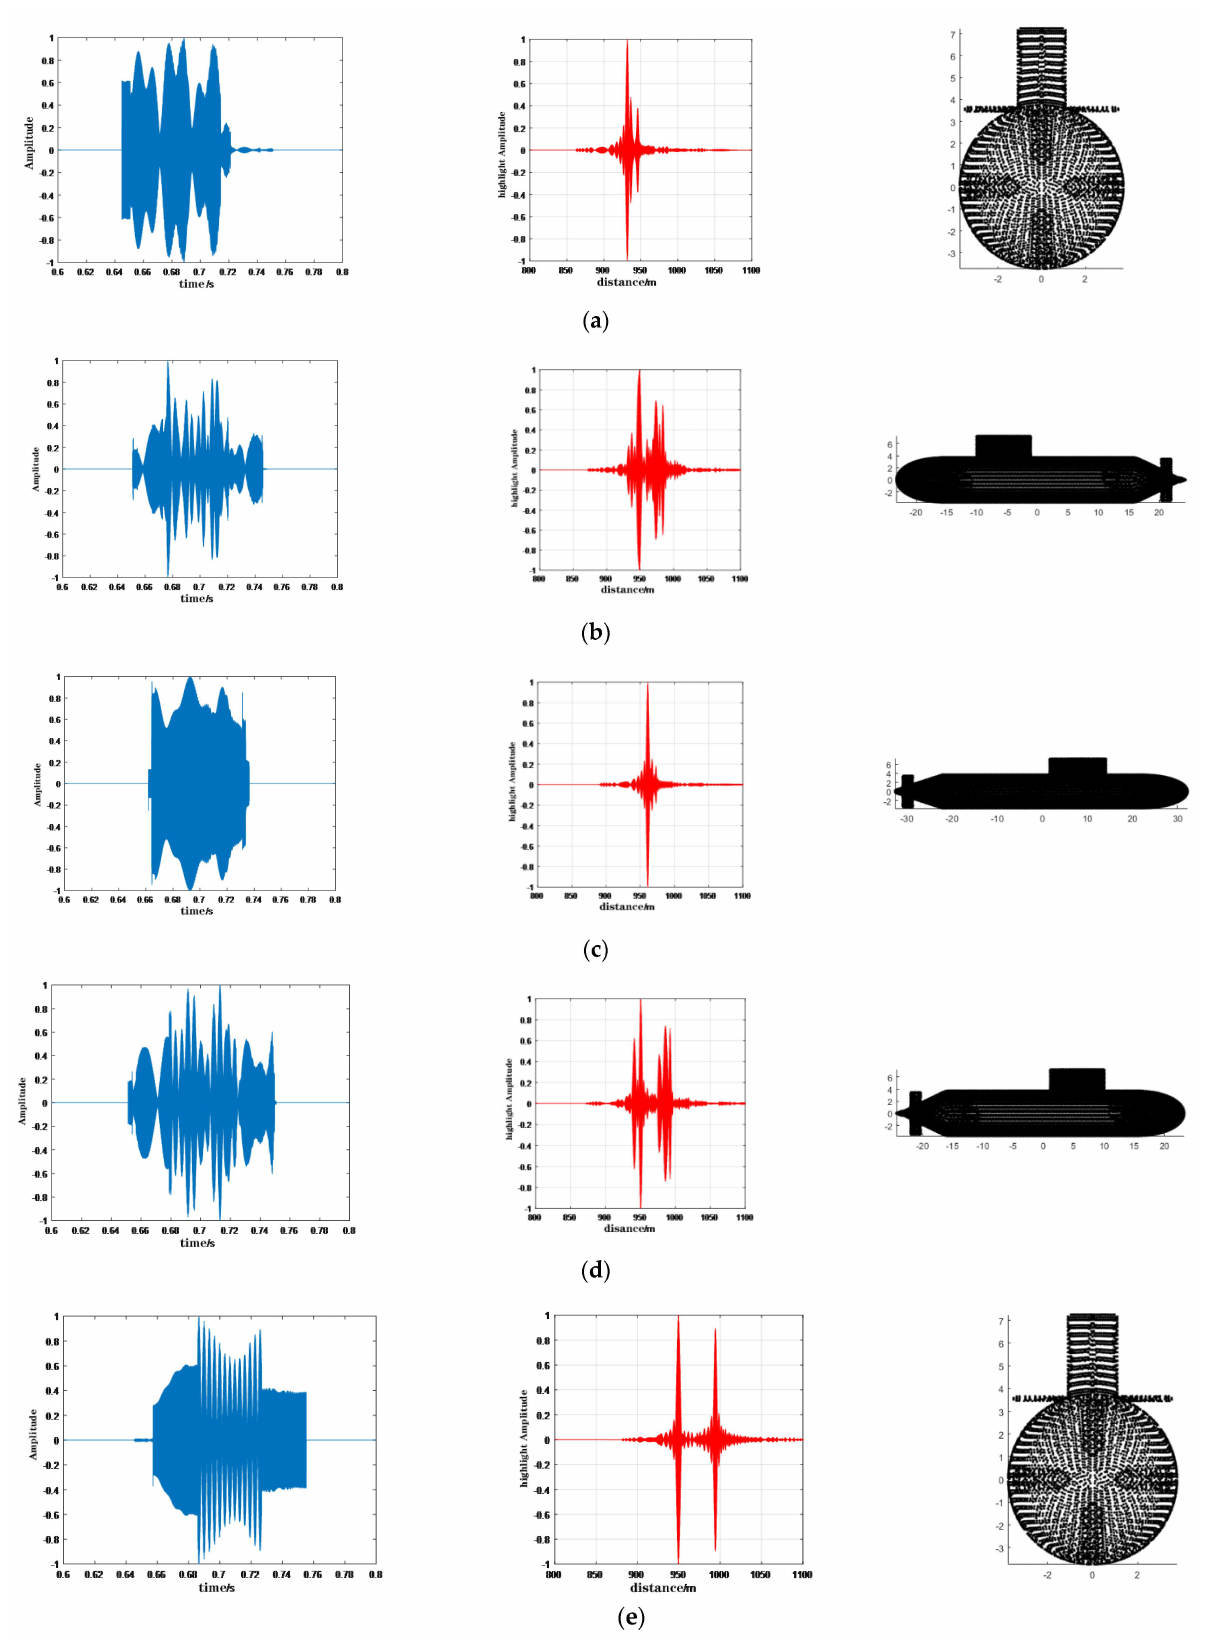
Figure 12. Time domain echo and highlight correlation analysis of linear frequency modulation (LFM) signal. ( a ) 0 degree; ( b ) 45 degree; ( c ) 90 degree; ( d ) 135 degree; and ( e ) 180